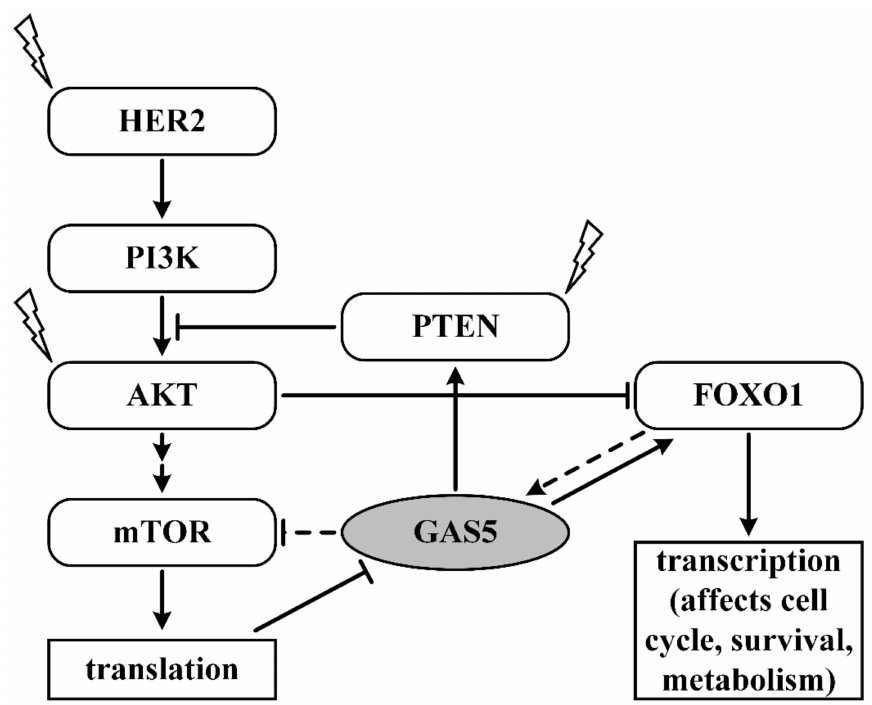
Figure 3. GAS5 and PI3K/AKT/mTOR pathway in breast cancer. Straight arrows: stimulation, blunt arrows: inhibitory effects, dotted line: estimated impact, lightning bolt: proteins often affected by mutations in breast cancer. Two consecutive arrows indicate other participants in the process, i.e., that the connection is not direct but occurs through